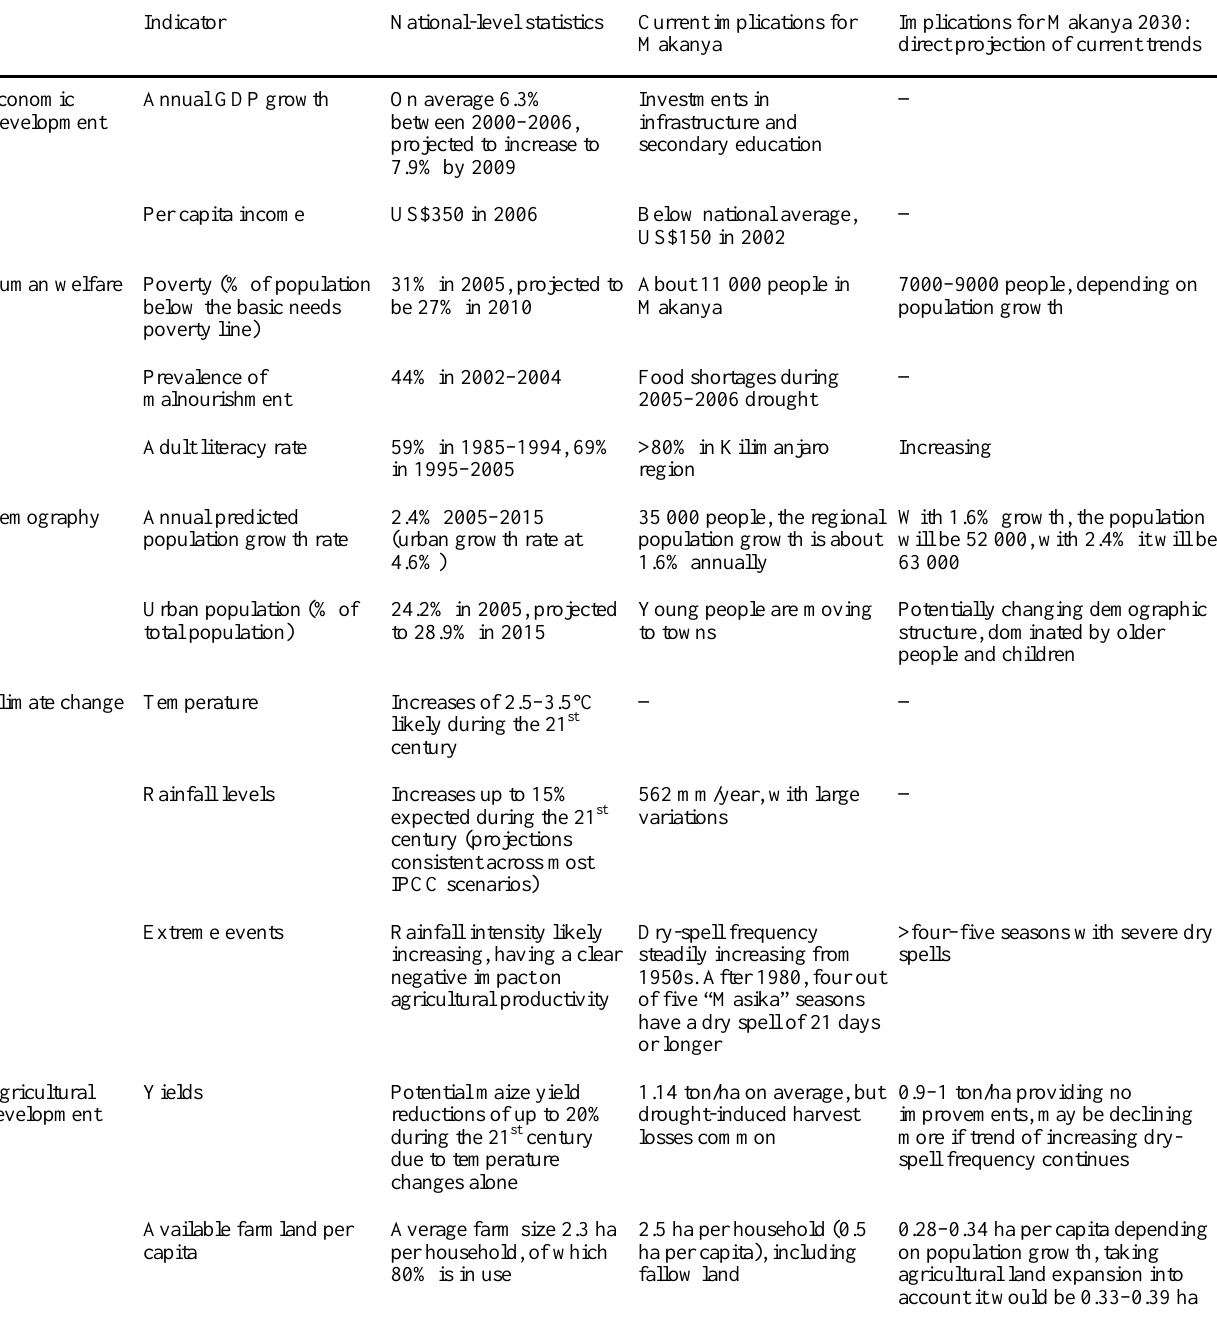
Table 1. Official statistics on current development trends in Tanzania. In the two last columns, we have interpreted the implications of these trends for Makanya catchment. Sources: The World Bank (2007), UNDP (2007), IPCC (Boko et al. 2007, Christensen et al. 2007, Easterling et al. 2007), and the United Republic of Tanzania (2001, 2002, 2005a, 2005b, 2006). Regional-, district-, and local-level data also come from FAO (2008), Same District Council (2006), and Enfors and Gordon